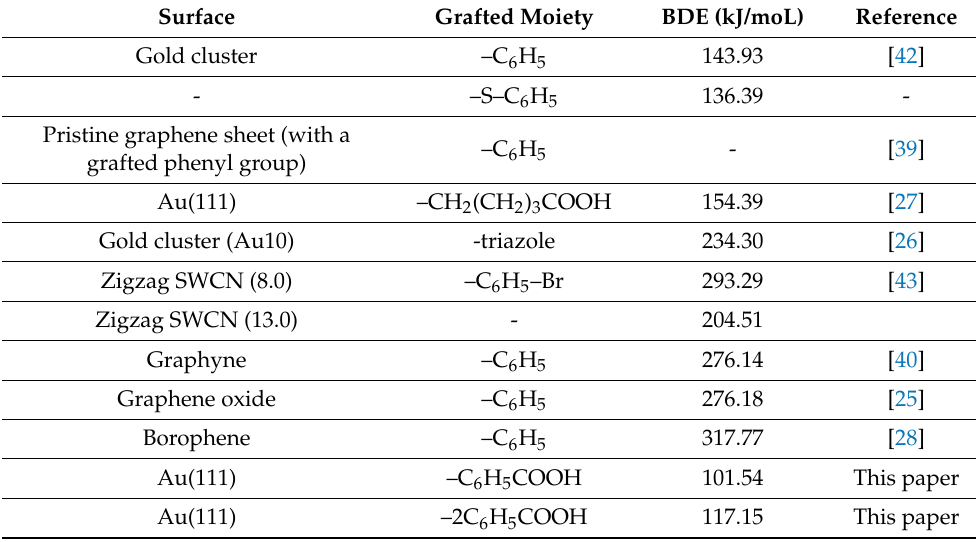
Table 4. BDE values of the grafted moieties on different